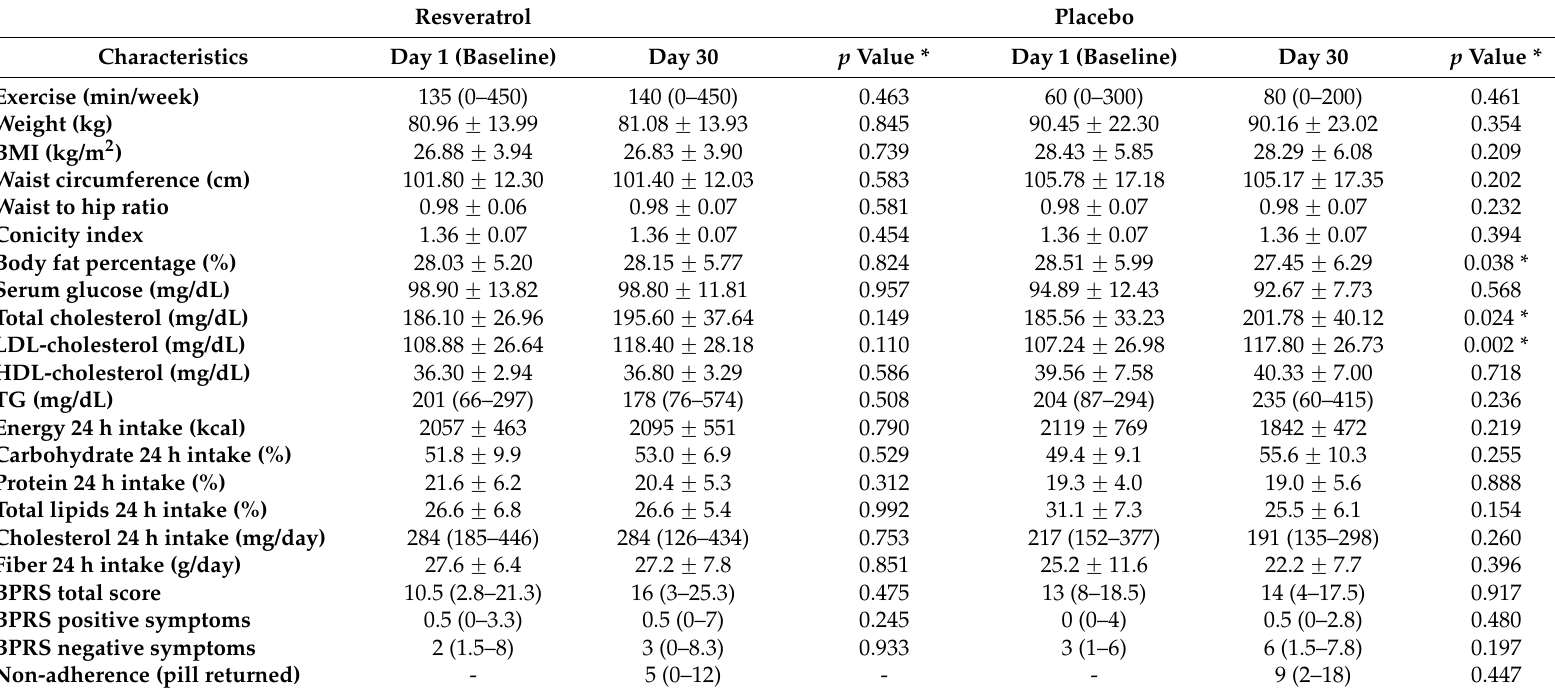
Table 2. Characteristics of subjects with schizophrenia at baseline and after 4 weeks of resveratrol supplementation or placebo. Resveratrol